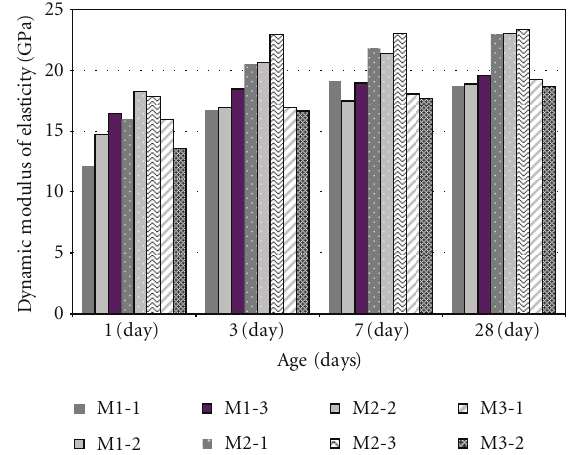
Figure 6: The dynamic modulus of elasticity for all tested specimens.